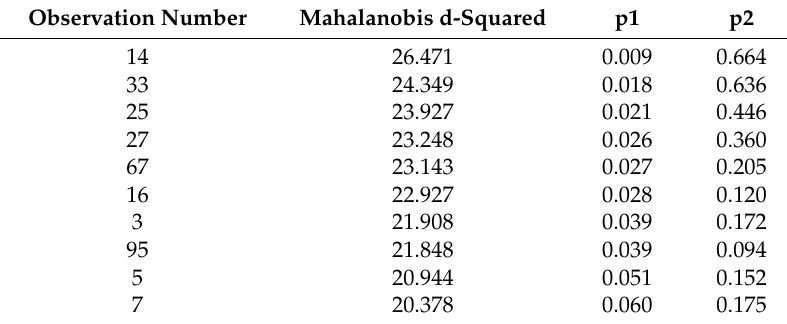
Table 1. Values of the squared Mahalanobise distance